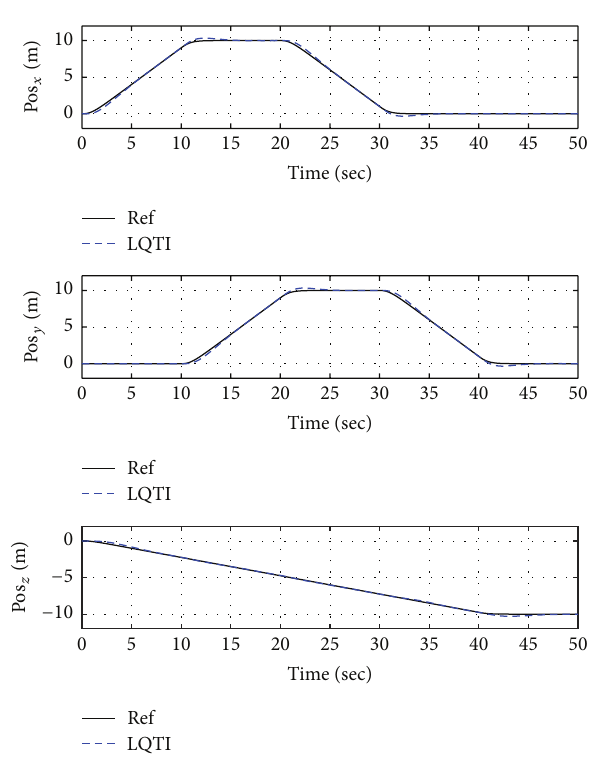
Figure 16: Time histories of position at hover mode (Case 2). Hover mode